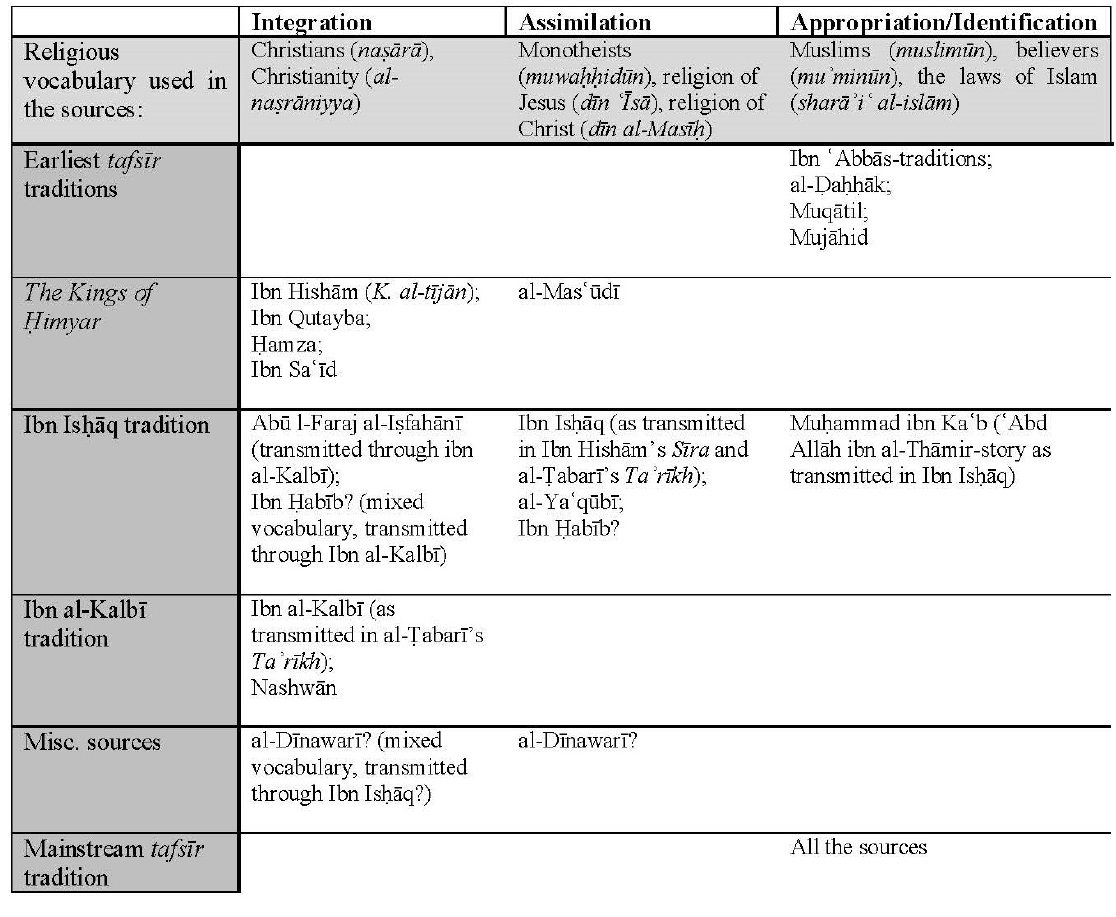
Figure 5 Table of the sources’ attitudes to and incorporation of the Martyrs of